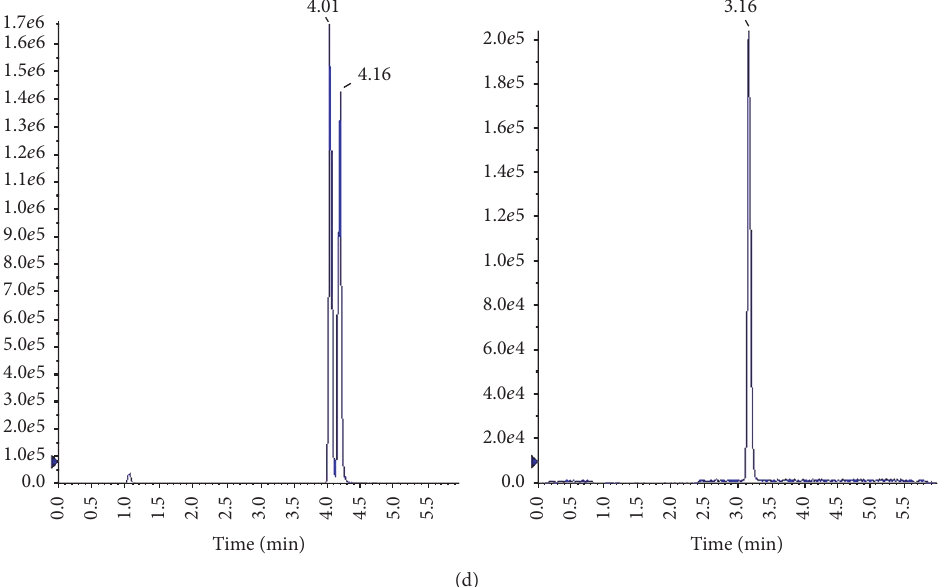
Figure 2: SIM chromatograms of psoralen, isopsoralen, and IS in rats plasma. (a) blank tissue; (b) blank tissue spiked with psoralen, isopsoralen, and IS; (c) kidney tissue sample of oral administration of crude scurfpea fruit; (d) kidney tissue sample of oral administration of salt-processed scurfpea